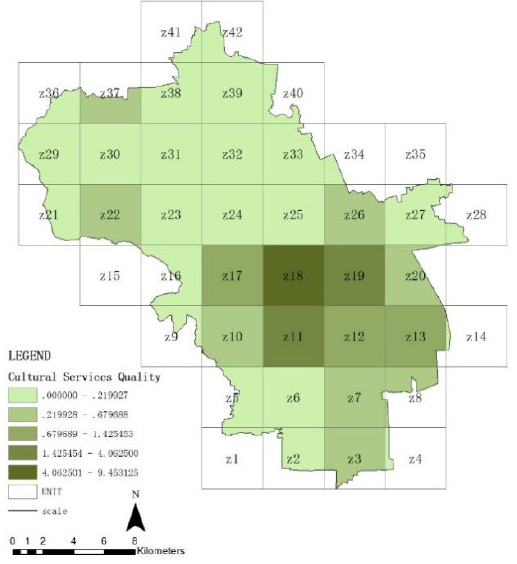
Figure 10. Quality distribution of cultural service of units.